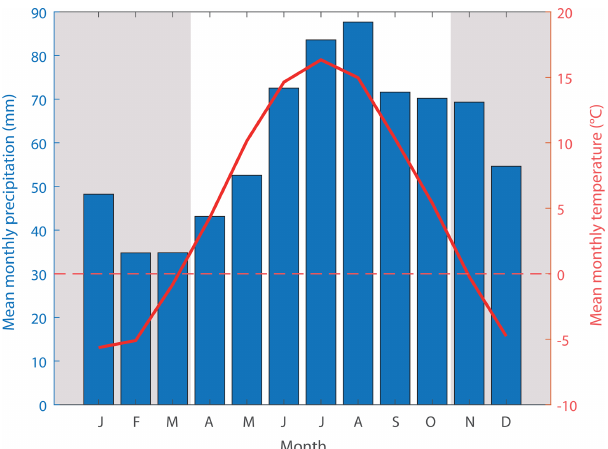
Figure 3. Mean monthly temperatures from 1961–2012CE and precipitation from 1945–2013CE recorded at the SMHI station Torsby, located ∼ 5km west of Lake Kälksjön (KKJ). Months with mean temperatures below 0 ◦ C are